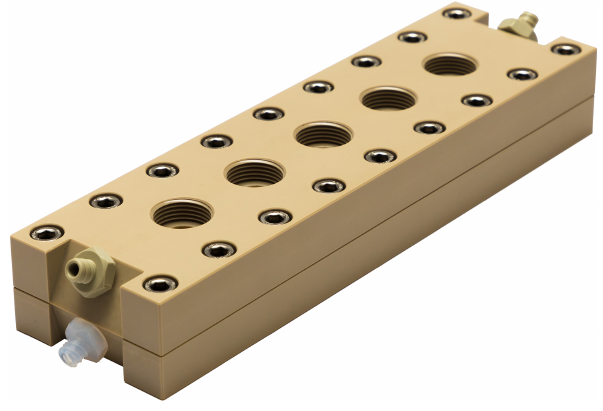
Figure 2. Photograph of the in-line measuring chamber for contin- uous monitoring of blood parameters in extracorporeal circuits.